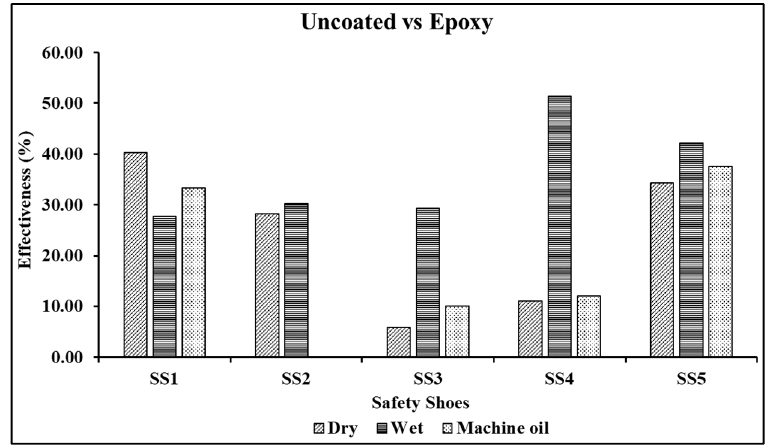
Figure 9. Effectiveness of epoxy-based coating as compared to uncoated laminate flooring across dry, wet, and machine oil contaminant conditions. wet, and machine oil contaminant conditions.